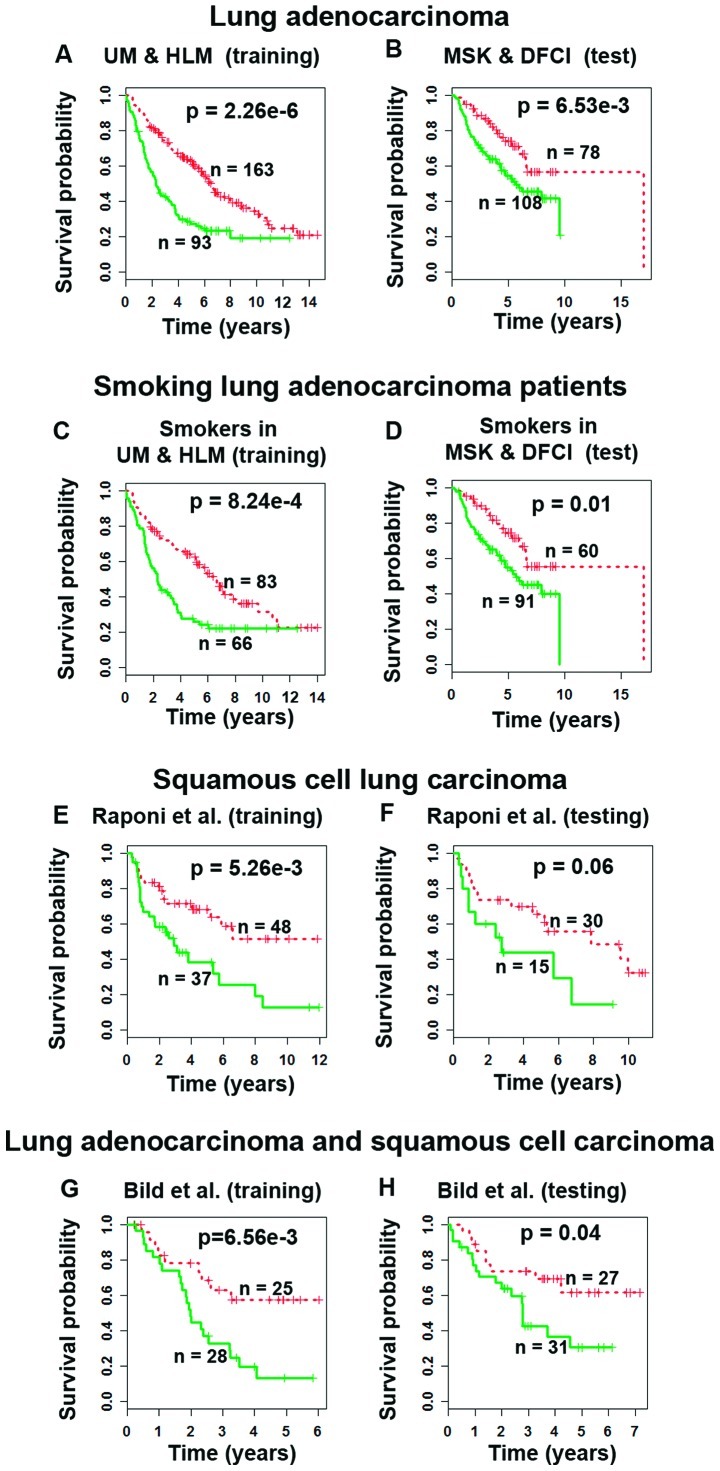
Prognosis in NSCLC patients using smoking-associated 7-gene signature. In the cohorts from Shedden et al(15), the risk score giving the best prediction on the 3-year ROC curve generated significant patient stratification (log-rank P<0.007) on the (A) training set and (B) independent test set. This classifier also stratified smoking lung adenocarcinoma patients into two distinct (log-rank P<0.01) prognostic groups in both the (C) training and (D) test sets. Significant stratifications were also obtained in the randomly partitioned training and test sets of patients with squamous cell carcinoma from (E and F) Raponi et al(16) and (G and H) the Bild cohort (17) of lung adenocarcinoma and squamous cell carcinoma. Log-rank tests were used to assess the statistical significance in survival probability between the two prognostic groups. Red curves, low-risk patient group; green curves, high-risk patient group.